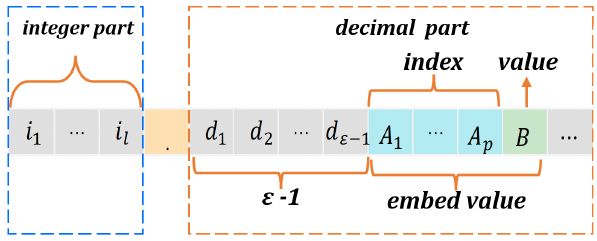
Figure 3. Watermarking embedding rule.